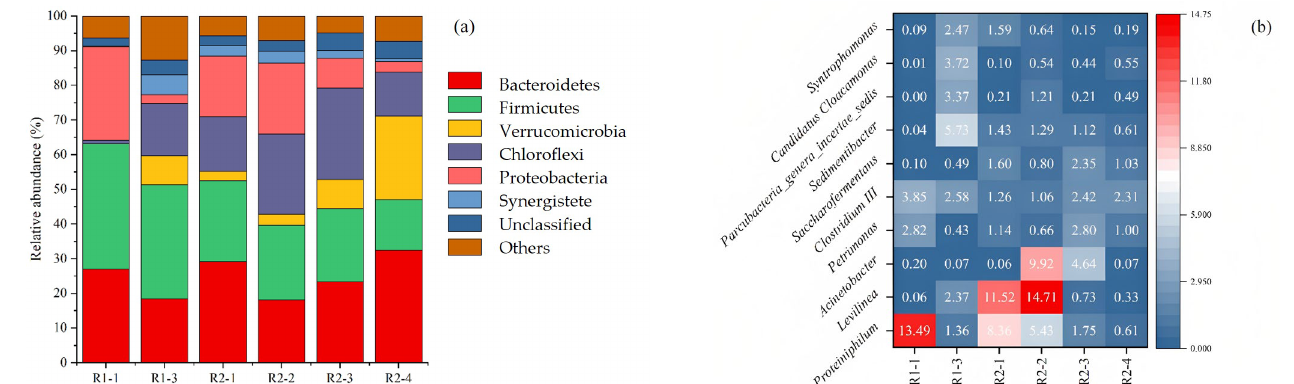
Figure 3. Bacterial sequence distributions: ( a ) Percent of bacterial community abundance at the phy- lum level; ( b ) Percent of bacterial community heatmap at the genus level. phylum level; ( b ) Percent of bacterial community heatmap at the genus level.